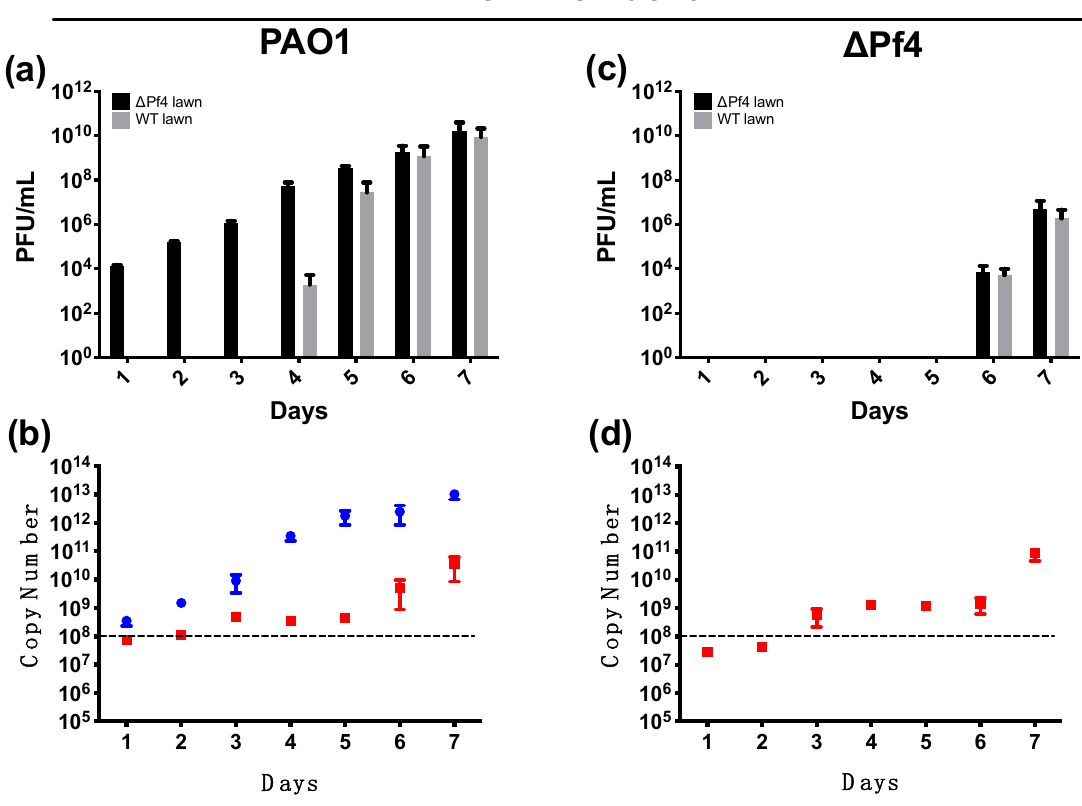
Figure 1. Phage production from biofilms formed by wild-type PAO1 ( a , b ) and the PAO1 ∆ Pf4 mutant ( c , d ). The bars in black ( █ ) represent the phage titre of the biofilm on a PAO1 Δ Pf4 top layer agar, while the bars in grey ( █ ) represent the biofilm phage titre on a PAO1 top layer agar ( a , c ). The points in blue ( ● ) and in red ( ■ ) indicate the amounts of Pf4 or Pf6 DNA, respectively, detected in the biofilm effluent ( c , d ). The amounts of phage DNA are represented as the calculated copy numbers and the limit of detection of 1 × 10 8 (indicated by the dashed line, ---). The biofilms were developed over 7 d. The error bars represent standard deviations. For all figures, there were 3 biological replicates with 3 technical replicates for each, i.e., N = 3 and n = 3.